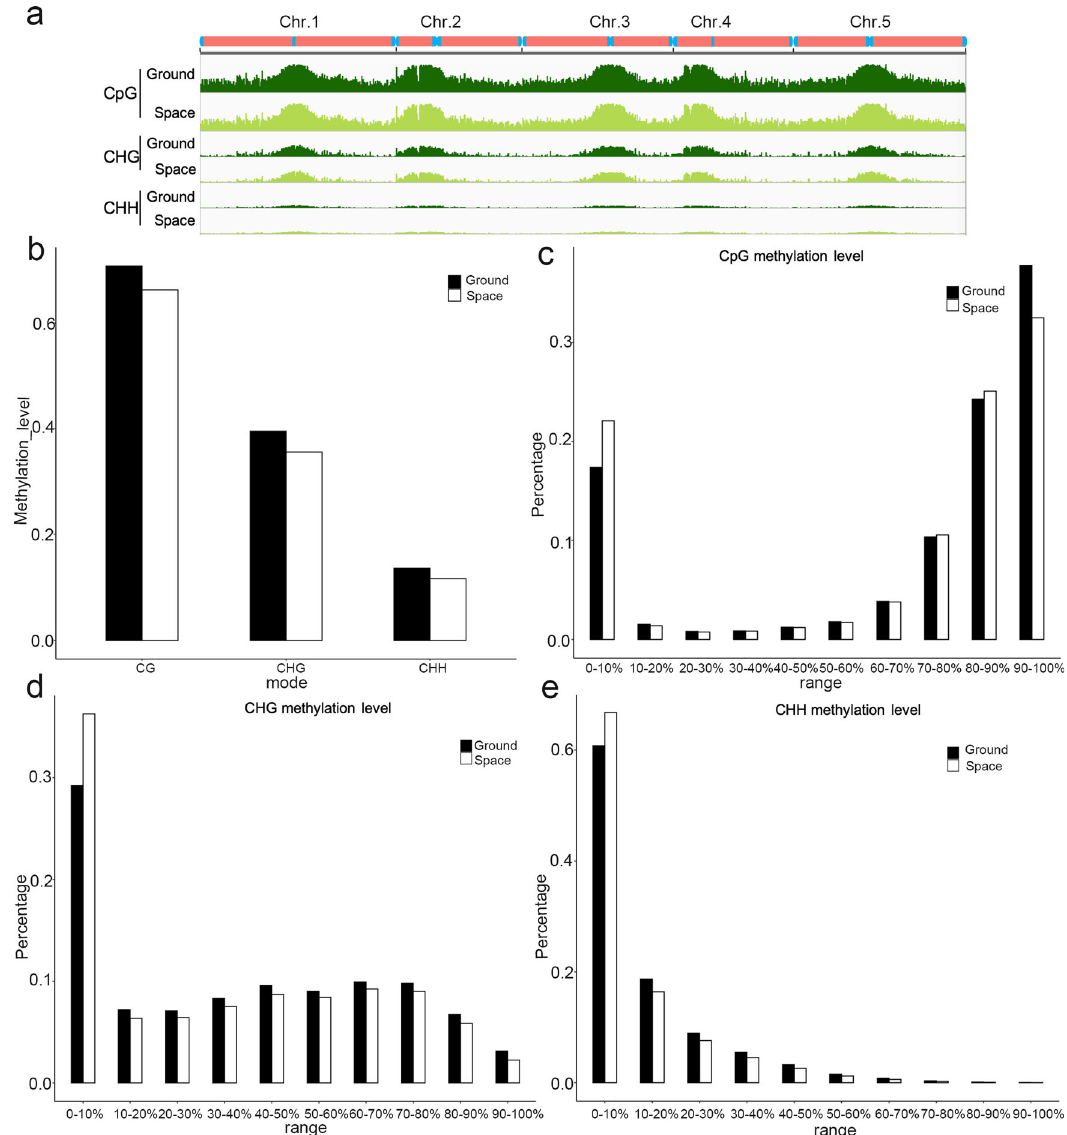
Fig. 4 DNA methylation patterns in the Arabidopsis genome of the F 1 generations of the space fl ight and ground control samples. a DNA methylation patterns are outlined in the F 1 generation. The Integrated Genome Viewer (IGV) 53 – 55 (http://software.broadinstitute.org/software/igv/) was used to visualize methylation levels of the CpG, CHG, and CHH contexts of chromosomes 1 – 5 of the offspring of space fl ight and ground control plants. Overview of genome-wide DNA methylation levels in the two samples are shown. b – e The bar chart lists the overall and proportional methylation of CpG, CHG, and CHH contexts in 10 separate boxes, corresponding to different methylation